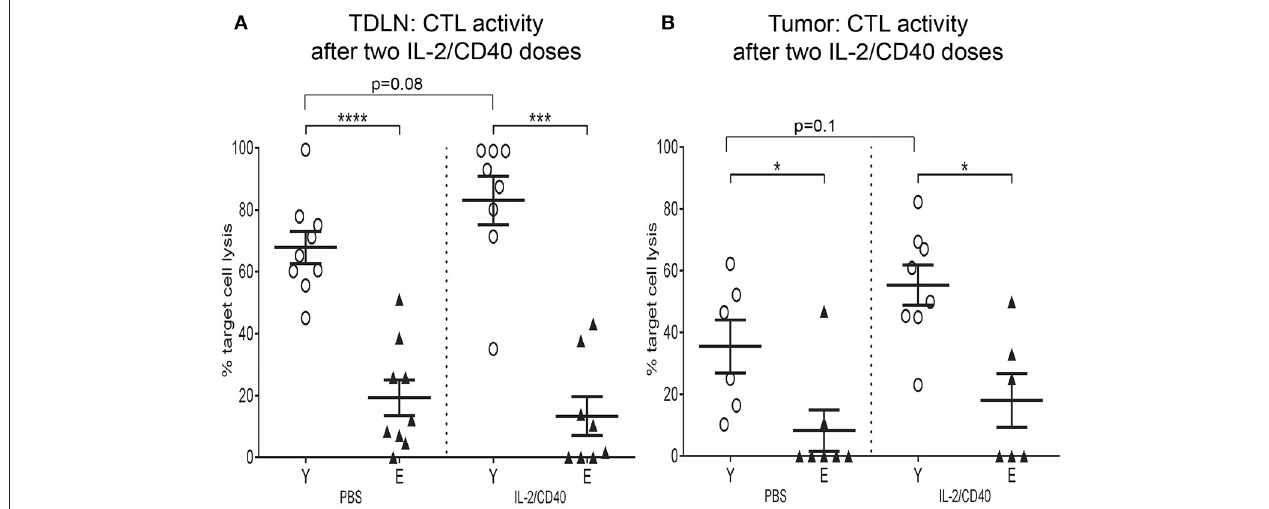
FIGURE 11 | Reduced tumor-specific CTL activity in elderly TDLNs and tumors. In a further experiment the cytotoxic activity of tumor-specific CD8 + CTLs was assessed after two doses of IL-2/CD40 or PBS diluent in TDLNs (A) and tumors (B) of young ( n = 17) and elderly ( n = 17) AE17sOVA-bearing mice using an in vivo CTL assay. SIINFEKL-pulsed and unpulsed target cells were injected into tumor-bearing mice, and ratios between percentages of the two target cell populations in TDLNs and tumors measured 18h later via flow cytometry. Data are shown for individual mice as well as mean ± SEM, mouse numbers differed on account of varying cell numbers available for analysis and ranged from n = 8 young and n = 6–8 elderly IL-2/CD40-treated mice, n = 6–9 young and n = 7–9 elderly PBS control mice, * p < 0.05, *** p < 0.0005, **** p < 0.0001 comparing young to elderly